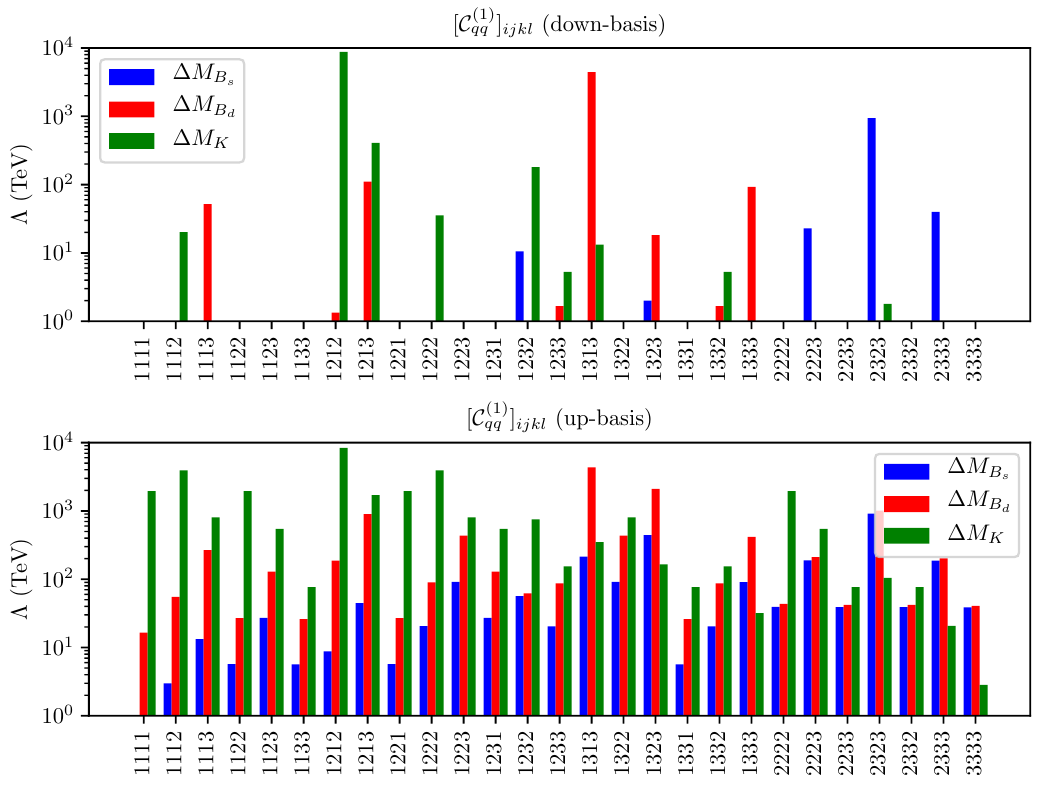
(cid:2) (cid:3) c (1) qq = 10 that corresponds to a 10% effect in ijkl